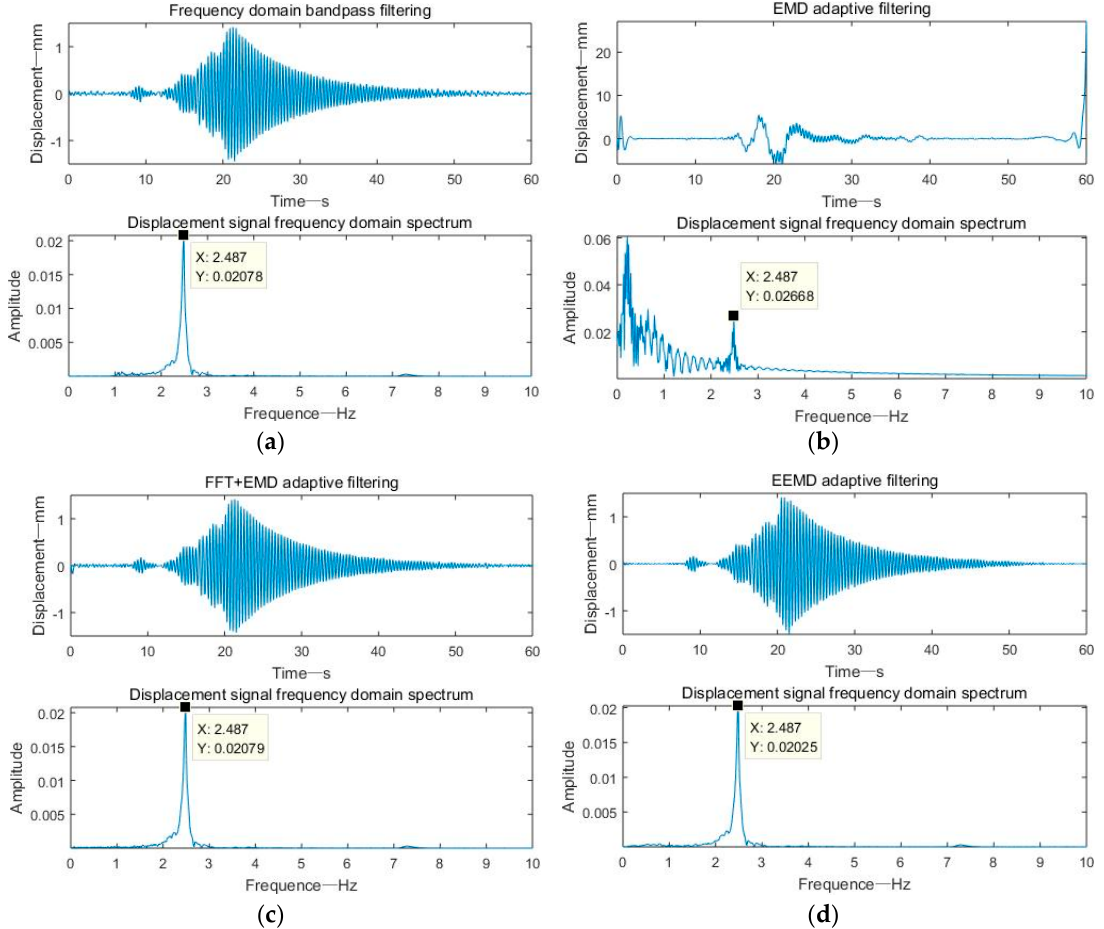
Figure 18. Four methods to realize dynamic displacement reconstruction of bridge: ( a ) Frequency domain bandpass filtering; ( b ) EMD adaptive filtering; ( c ) FFT + EMD filtering; ( d ) EEMD adaptive